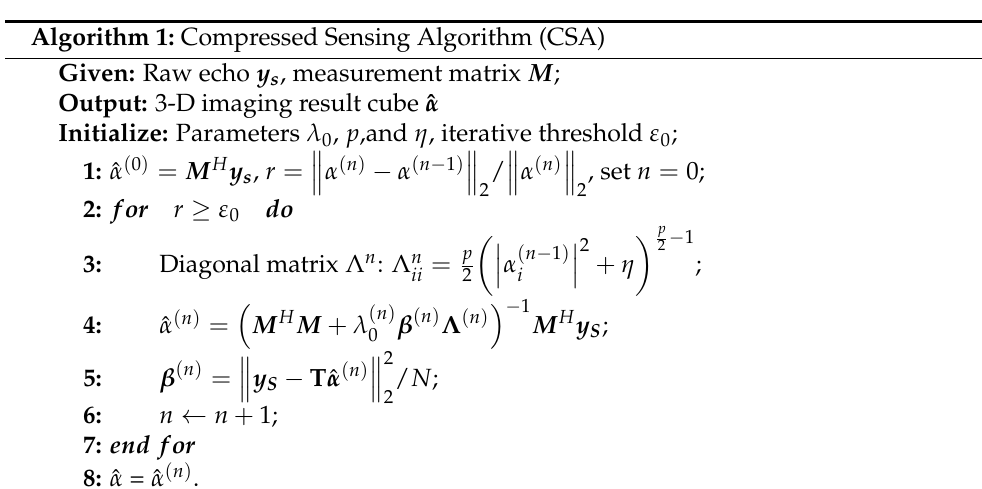
Algorithm 1: Compressed Sensing Algorithm